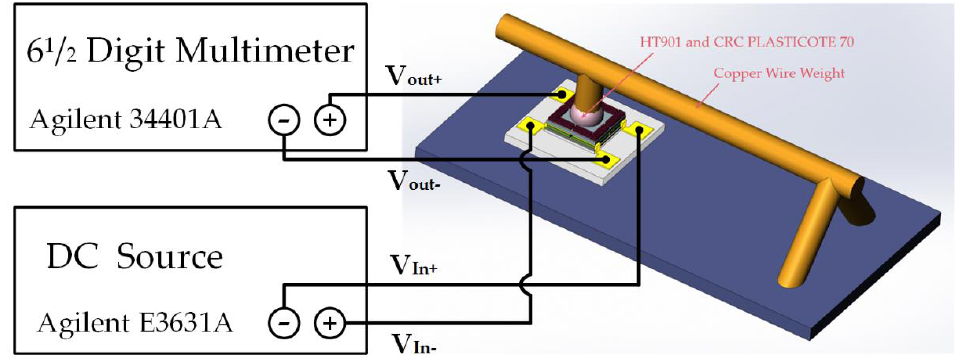
Figure 16. Schematic of the actual measurement setup.